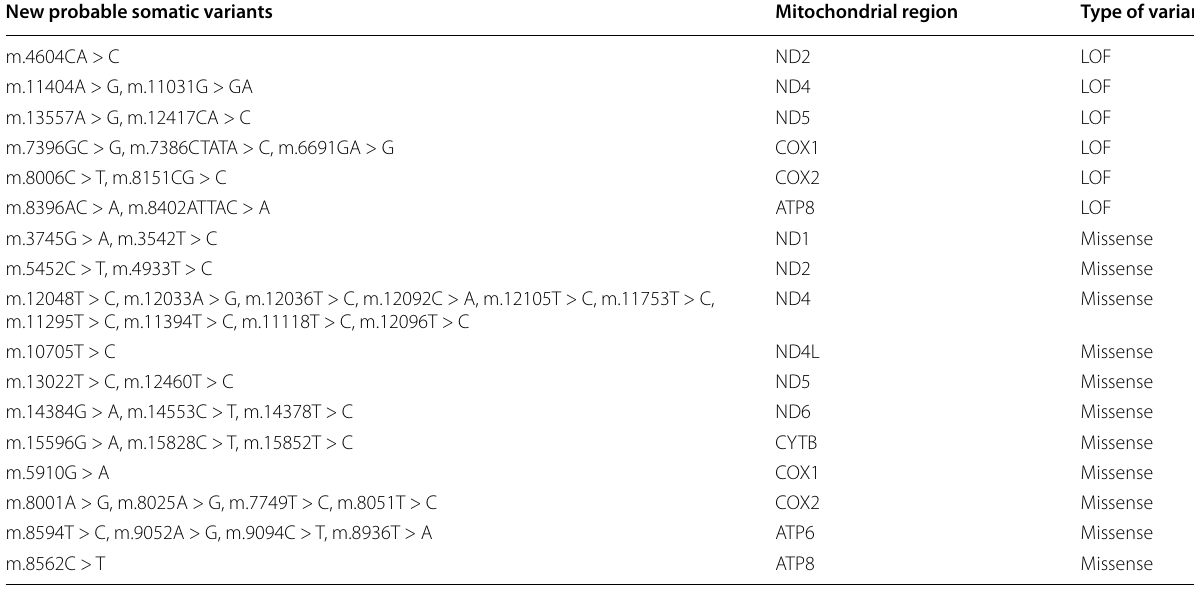
Table 5 List of the new probable somatic variants at various base positions (column 1) in the mitochondrial genome after comparing five pairs of patient and sibling samples using MuTect2 and ruling out germ-line and known COSMIC somatic variants, encoding for various regions (column 2) and the type of variant (column 3) New probable somatic